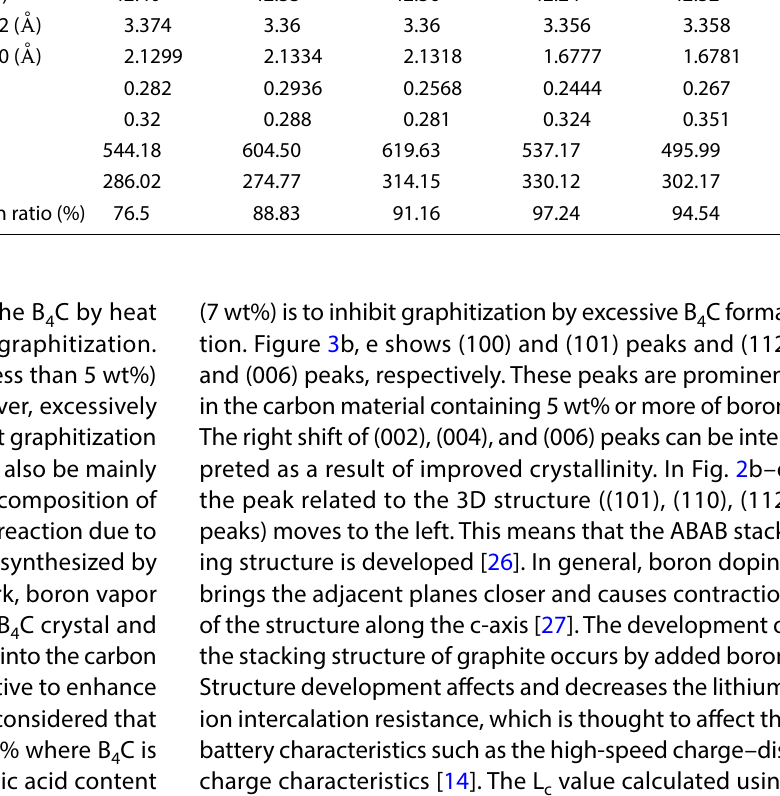
Table 4 Calculated XRD value of